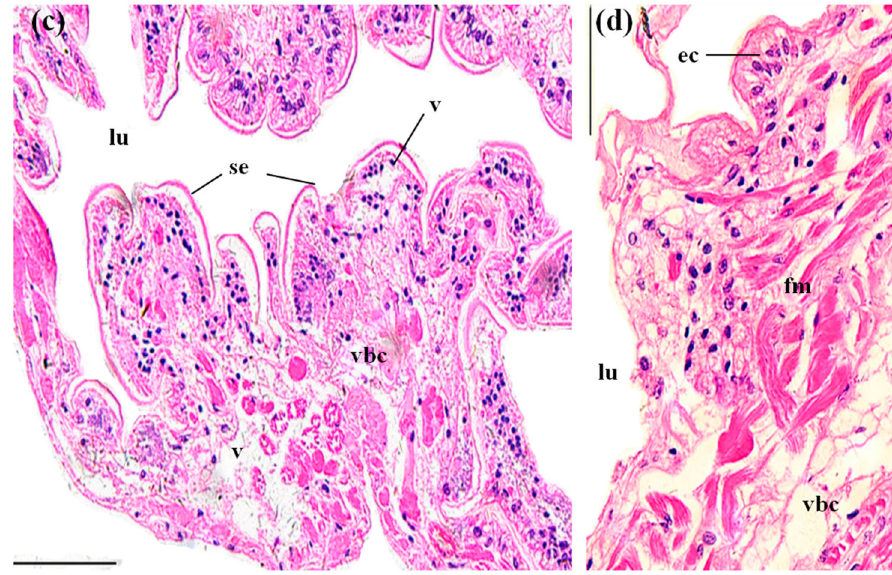
Figure 6. The midguts of P. clarkii after 96 h exposure to: a control solution ( a , b ); and 72.62 mg/L MBA ( c , d ). ( a ) Control midguts with uniform arrangement of the cuticula (cu), epithelial cells (ec), bladder cells (bc) and longitudinal muscles (lm) (200 × ). ct: connective tissues. ( b ) Control midguts with uniform arrangement of the longitudinal muscles (lm) and the bladder cells (bc) (400 × ). ( c ) Damaged midguts exhibited separation of the epithelium from the cuticula (se), vagueness (vbc) and lysis, and vacuolation in some bladder cells (v) (200 × ). ( d ) Damaged midguts exhibited some vagueness of the bladder cells (vbc) and fracture of the longitudinal muscles (fm) (400 × ). ec, epithelial cell; lu, lumen. H&E stain, scale bars = 100 µ m.